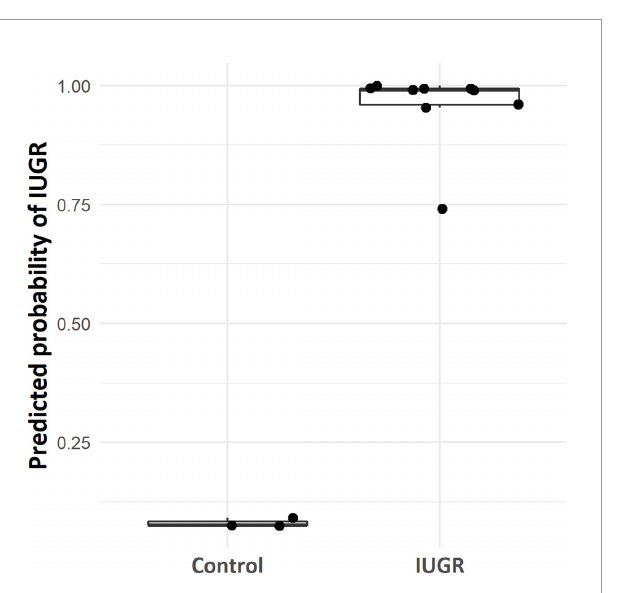
FIGURE 5 | Box plot of case-control model predicted probability according to IUGR/control